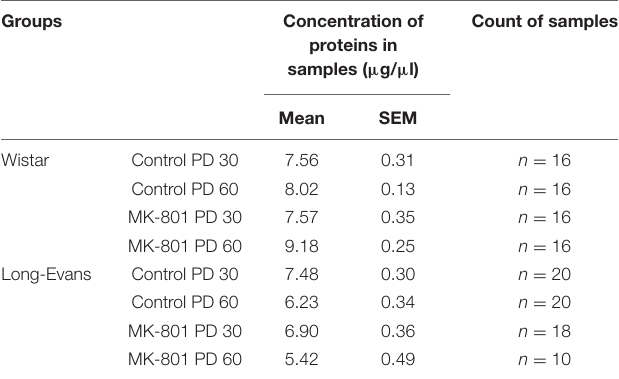
TABLE 1 | Mean of total protein concentration in samples for Western blot analyses. Groups Concentration of